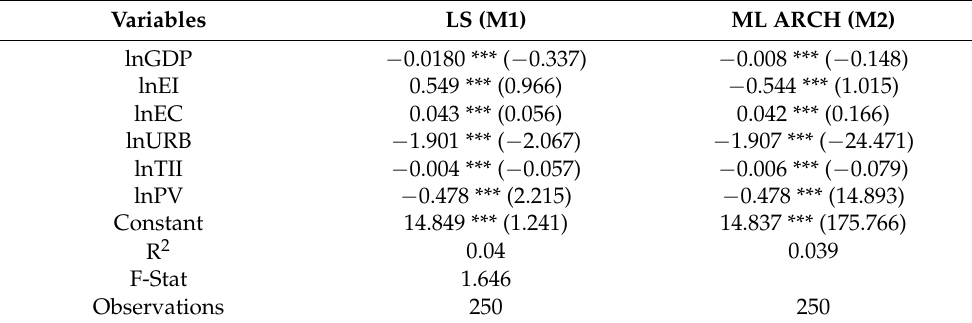
Table 9. Panel estimation results: Gauteng CO 2 - eq emissions in the transport